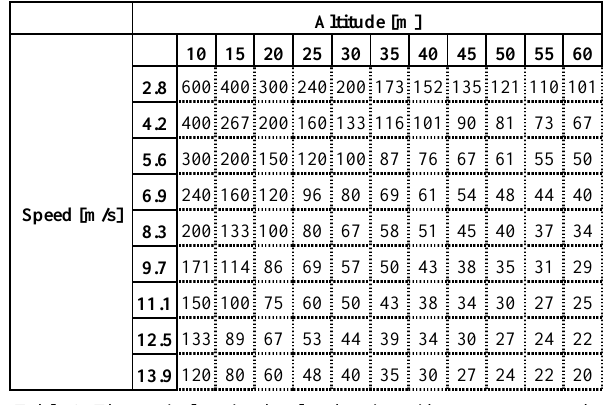
Table 3. Theoretical emitted pulse density with respect to speed and altitude (based on Yellowscan, 2015)